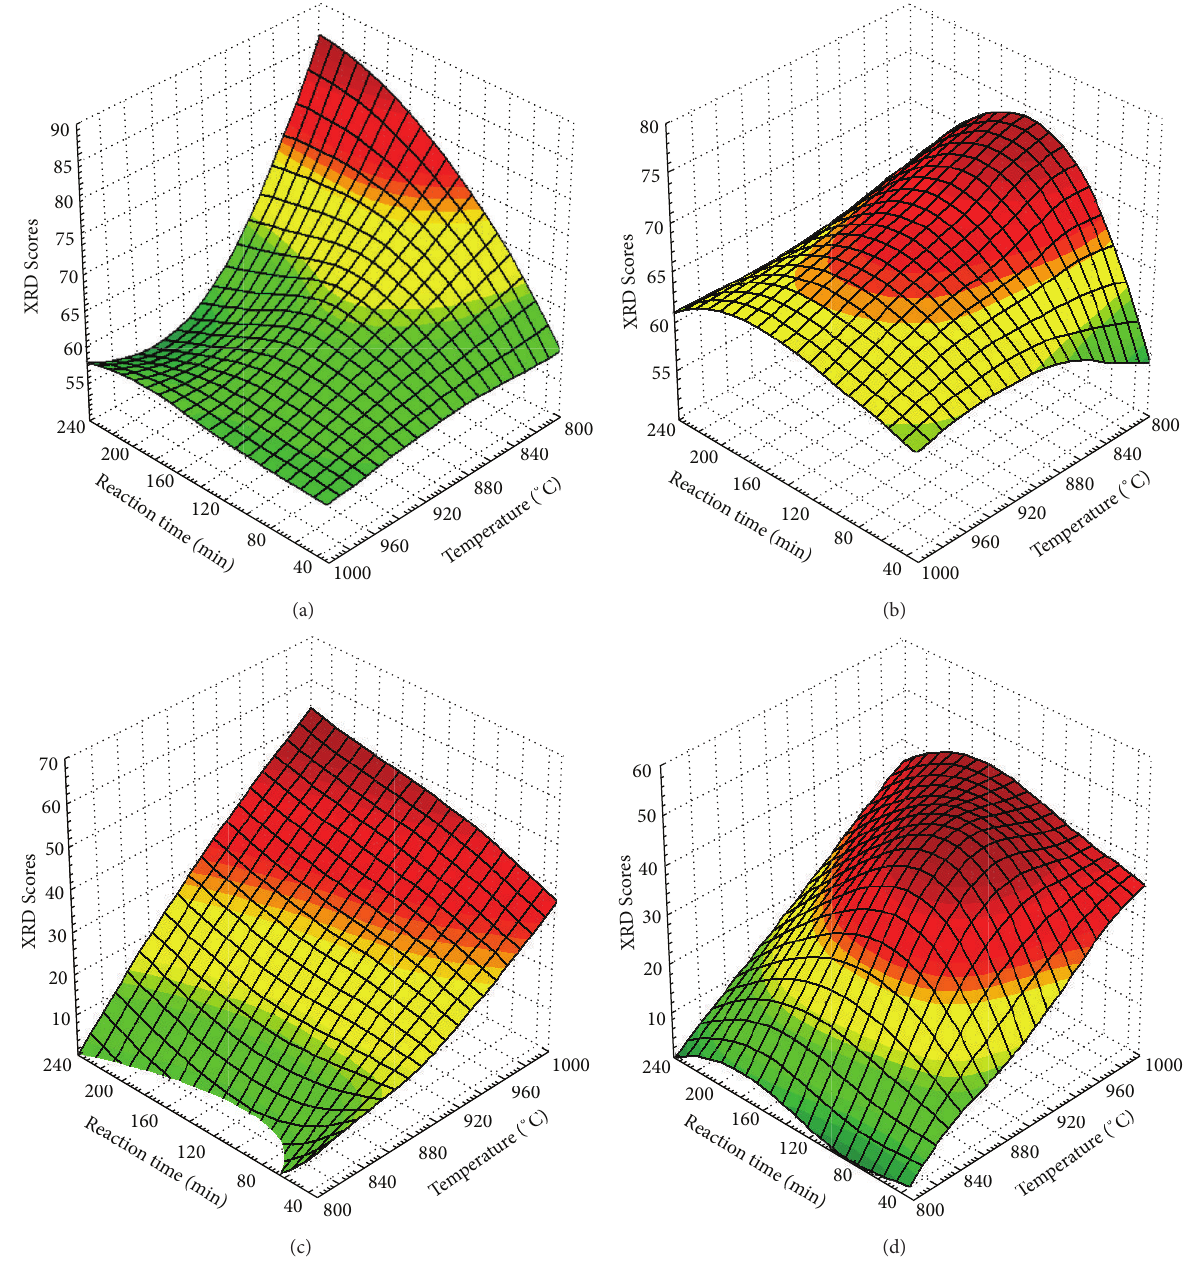
Figure 2: Three dimensional model graph of dehydrated magnesium borate formation; (a) K (1: 1), (b) K (3:2), (c) MB 1 (1:1), (d) MB 1 (3:2).